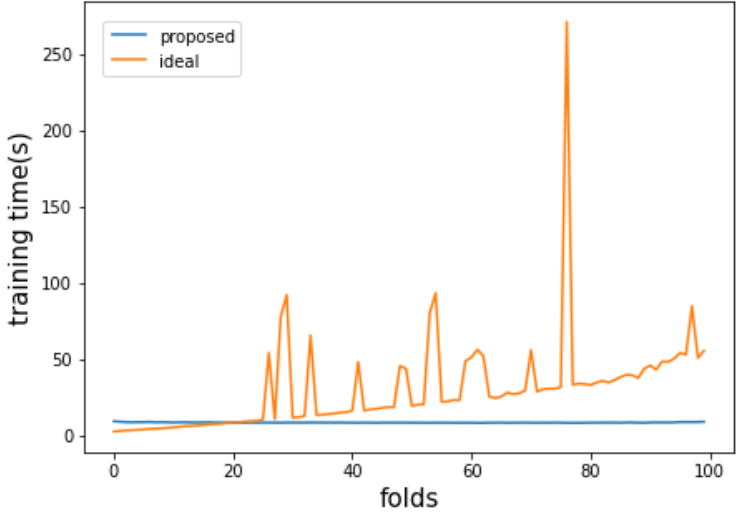
Figure 4. Training time per unit data input of the proposed method and the ideal method when the size of the pure dataset is 20,000.